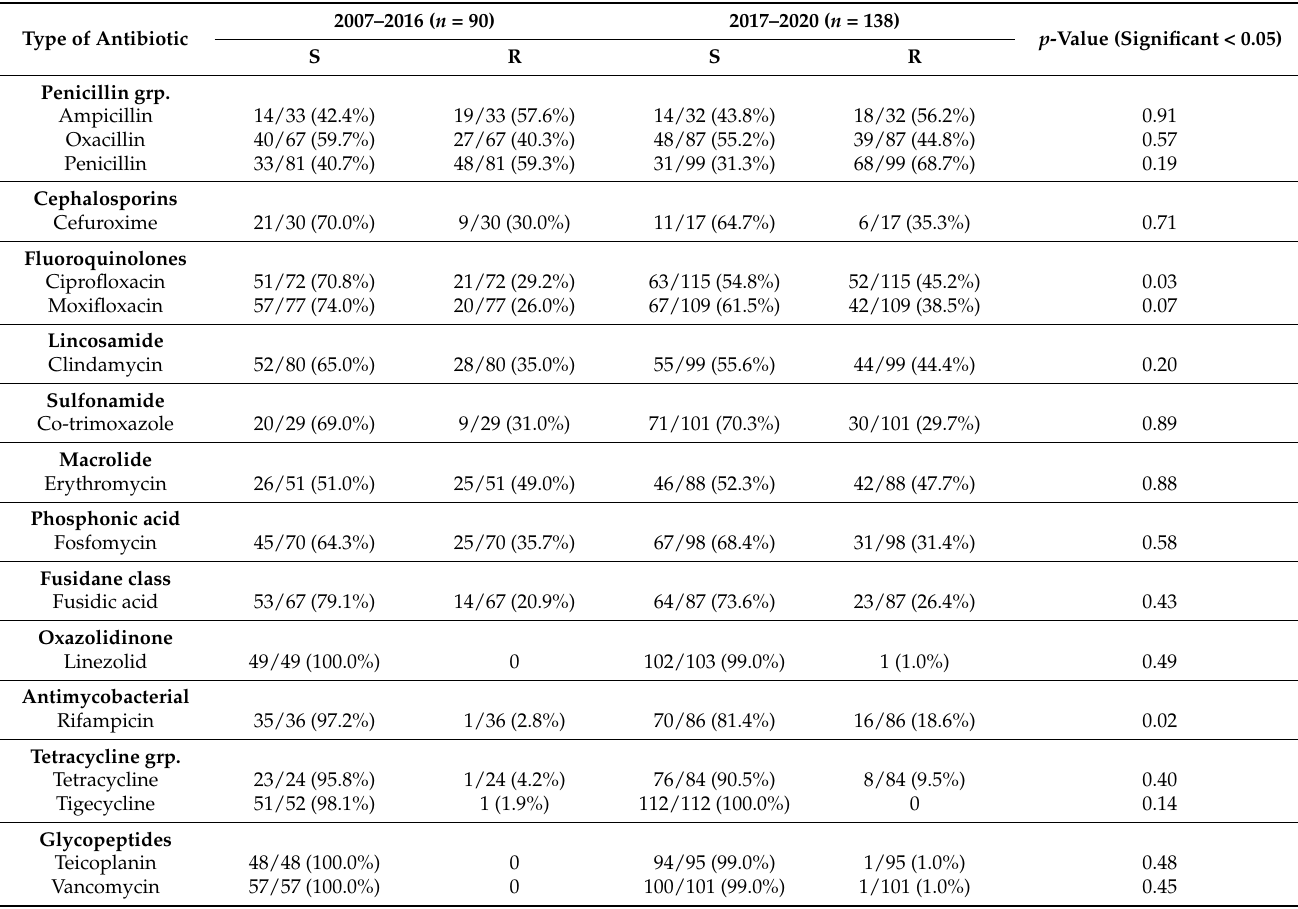
Table 5. Antibiotic resistance of 17 different types of antibiotics and the statistical significance, comparing two chronological